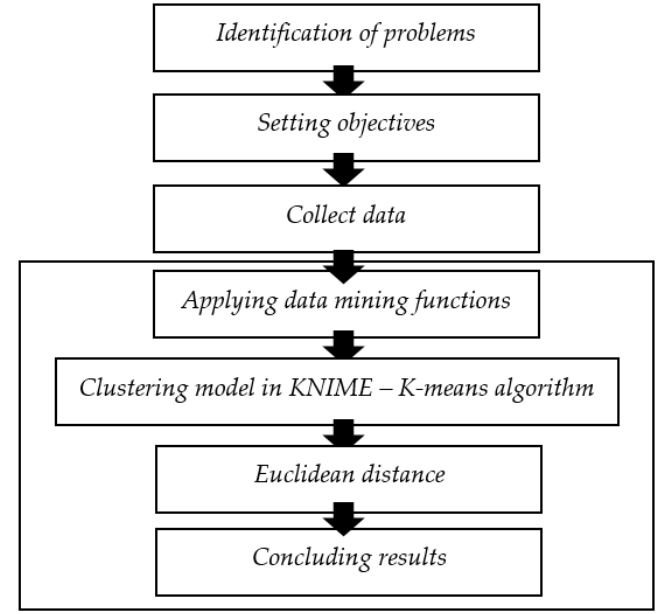
Figure 4. Research framework analysis techniques. Source: authors’ compilation.